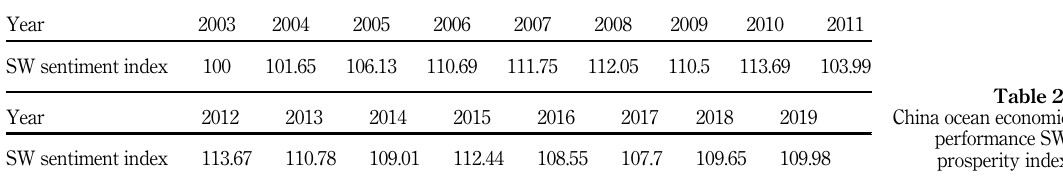
Table 2. China ocean